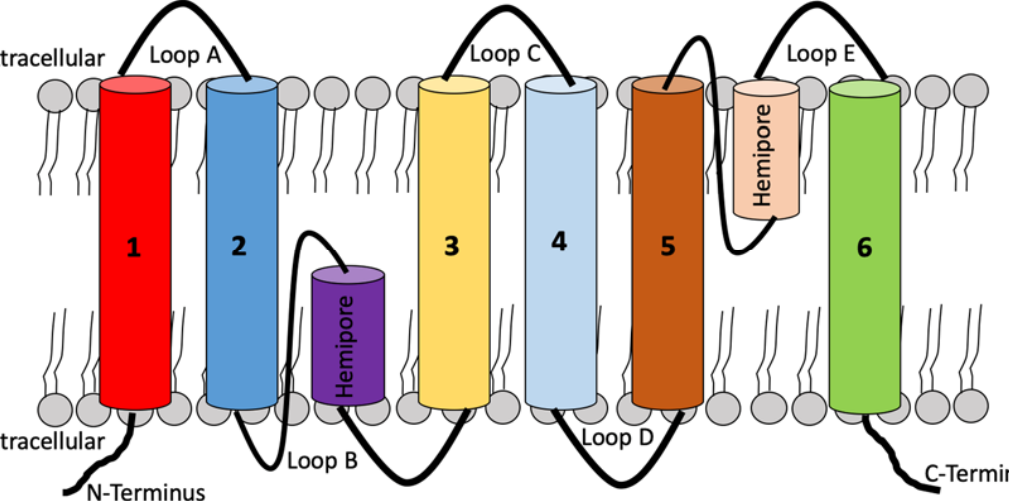
Figure 1. Two ‐ dimensional structure of AQP1 based on six transmembrane pores and two hemi pores helices.